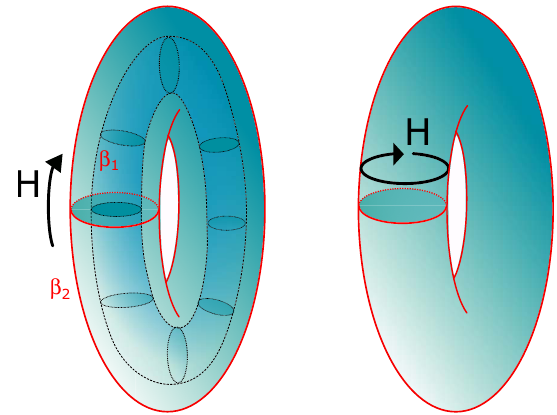
Figure 17 . Left: annulus partition sum Z with (vertical) length β the outer tube. Right: limit where β the interior of the S -dual